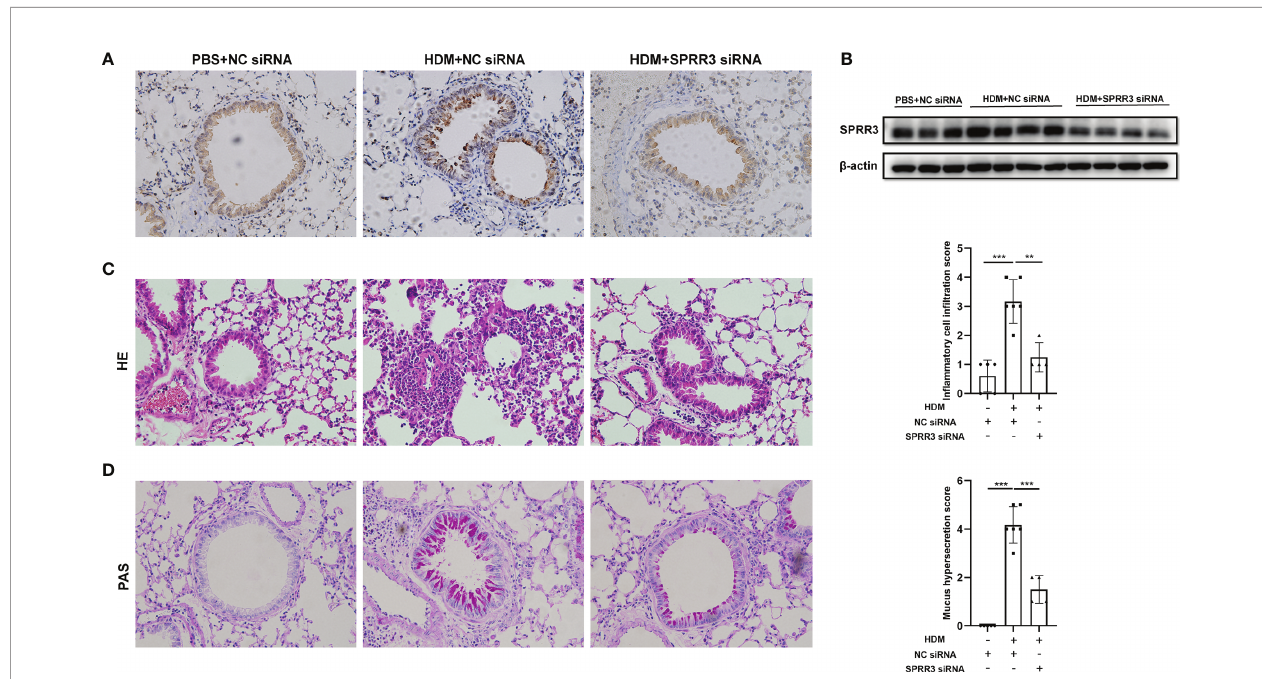
FIGURE 2 | SPRR3 knockdown alleviates house dust mite (HDM)-induced airway in fl ammation and mucus secretion in mice. (A) Immunohistochemistry staining of the lung to assess the expression of SPRR3 (original magni fi cation, ×200). (B) SPRR3 protein levels in mouse lungs determined by Western blotting. (C) Representative lung sections stained with H&E (original magni fi cation, ×200) and histopathological scores of airway in fl ammations. (D) Representative lung sections stained with periodic acid-Schiff (PAS) (original magni fi cation, ×200) and histopathological scores of airway mucus secretion. Values represent mean ± SEM, n = 4 – 6 for each group. ** p < 0.01, *** p <